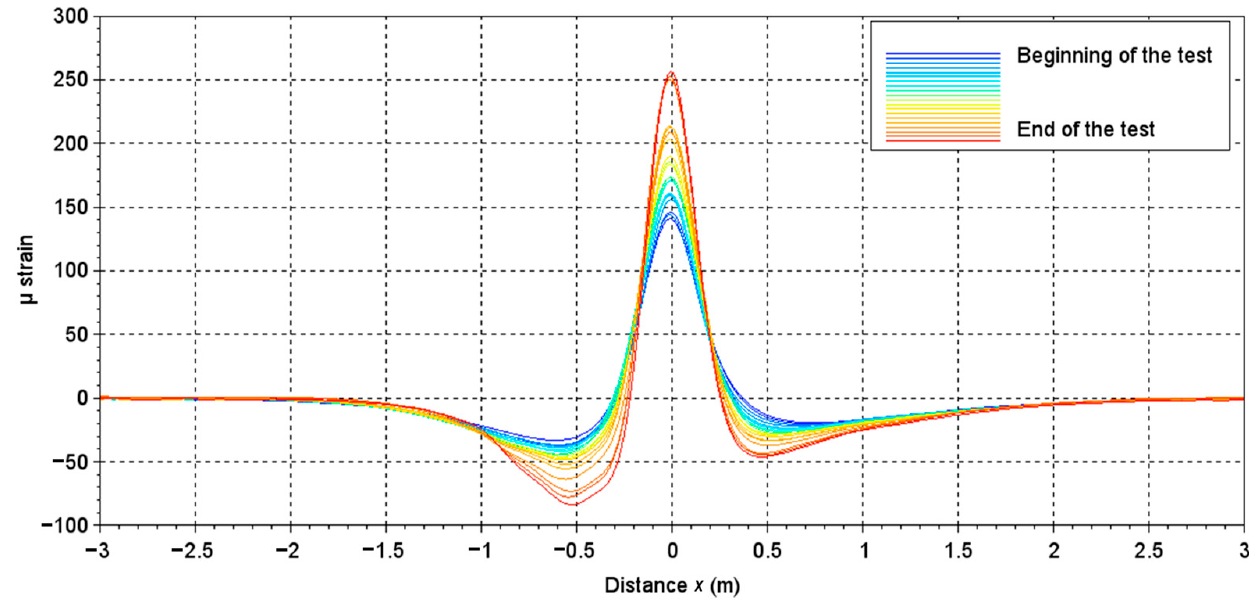
Figure 10. Evolution of gauge signals with the loading, from 151,200 loadings (beginning of the test) to 881,600 loadings (end of test).